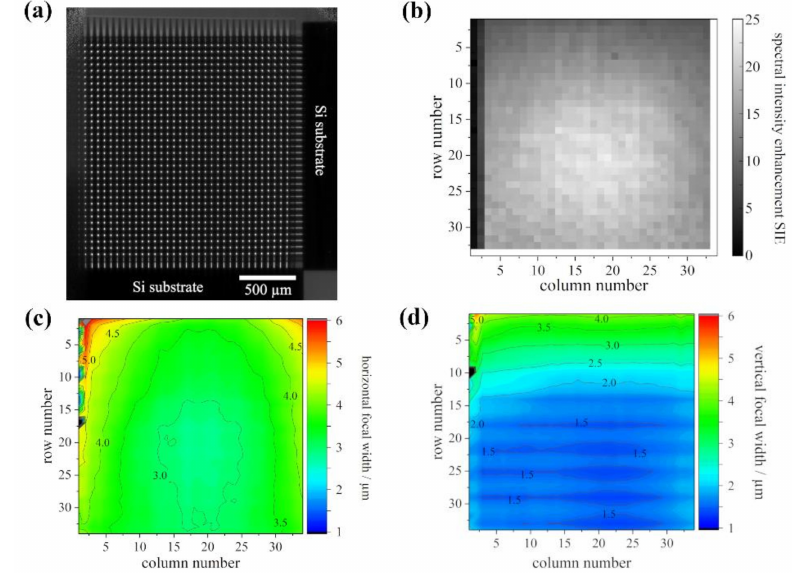
Figure 3. X-ray characterization of 2D multi-lens array: ( a ) High resolution detector image of the 34 × 34 foci generated by the multi-lens array. ( b ) SIE of the 34 × 34 arrays at the focal distance, using an area of 1.8 µ m × 1.8 µ m ( E = 34 keV). SIE of the first and second sub-CRL columns was weak due to a small misalignment of one mounting frame connecting the two 1D half lenses (shadowing). Horizontal ( c ) and vertical ( d ) focal width (full width half maximum, FWHM) of the 34 × 34 multi-lens array shown as a contour plot. The ordinate states the row number of sub-CRLs and the abscissa states the column number of sub-CRLs (Si substrates to the right and bottom, corresponding to Figure